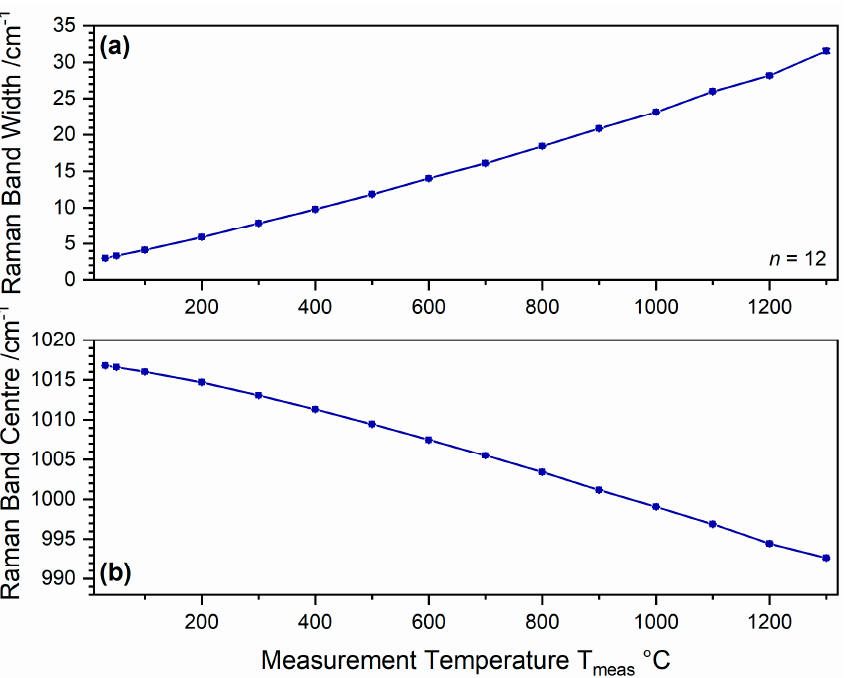
Figure 4. Development of ( a ) width (full width at half maximum, FWHM) and ( b ) peak centre of the most prominent Raman band of anhydrite II ( ν 1 ) as a function of measurement temperature.